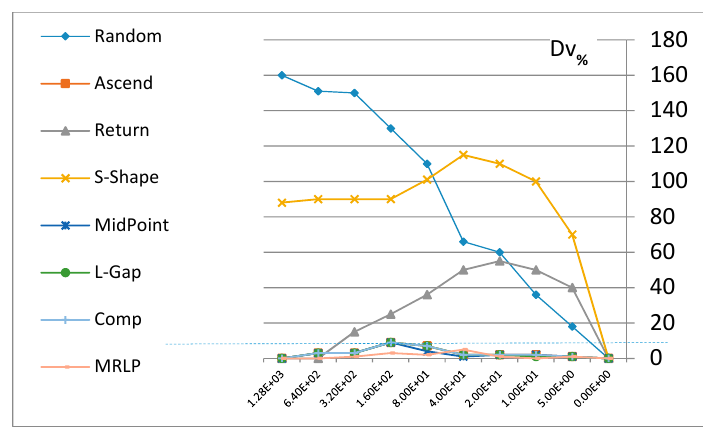
Figure 6. Best published heuristic results. Processes 2020 , 8 , x FOR PEER REVIEW